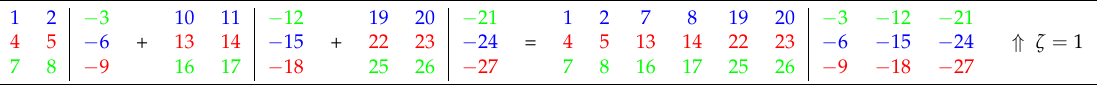
(ph1: blue, ph2: red, ph3: green). Table 10. WDT for a double-layer, three-phase winding with N = 27, m = 3 and p = 3 considering all coil